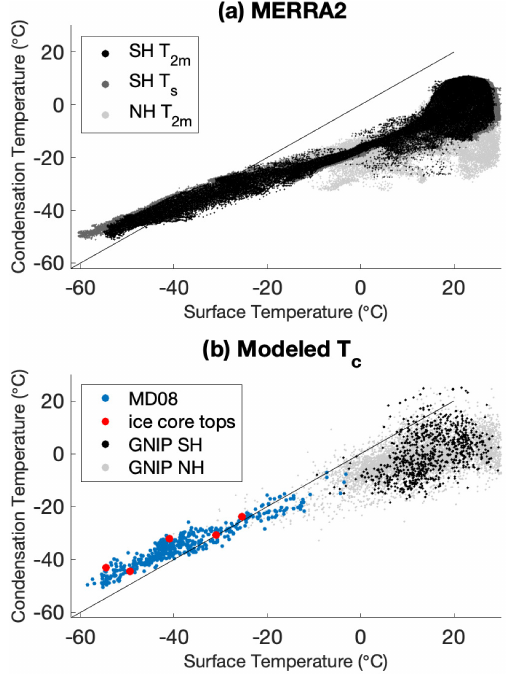
Figure A9. Weighted condensation temperature as a function of surface temperature. (a) MERRA-2 reanalysis data for 2008–2017. Seasonally and vertically weighted condensation temperature (ac- counting for reevaporation and condensation) for every grid point in the Southern Hemisphere against 2m air temperature (black) and surface temperature (dark grey). The same relationship with 2m air temperature is shown for the Northern Hemisphere as light grey dots. (b) The reported surface temperature and the SWIM- modeled condensation temperature using pairs of δ 18 O and δ D in the Masson-Delmotte et al. (2008) database (MD08, blue dots) from both Southern Hemisphere sites (black dots) and Northern Hemi- sphere sites (light grey dots) in the GNIP database, as well as the average of the top 50 years of sites from several deep ice-core sites (red dots). Solid black lines are 1 :